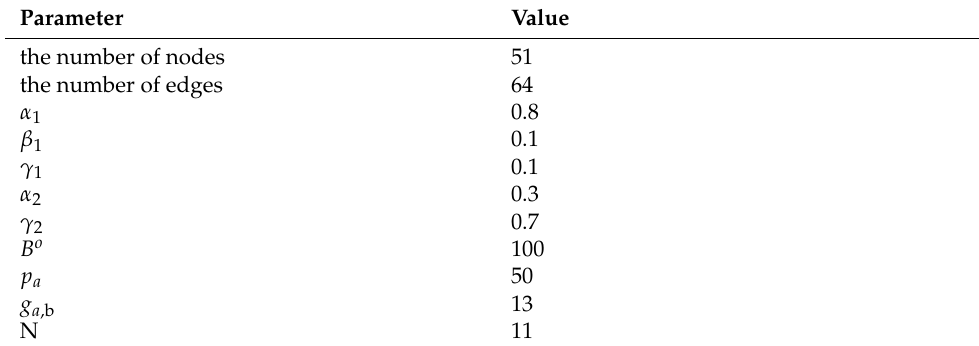
Table 3. Simulation Parameters.